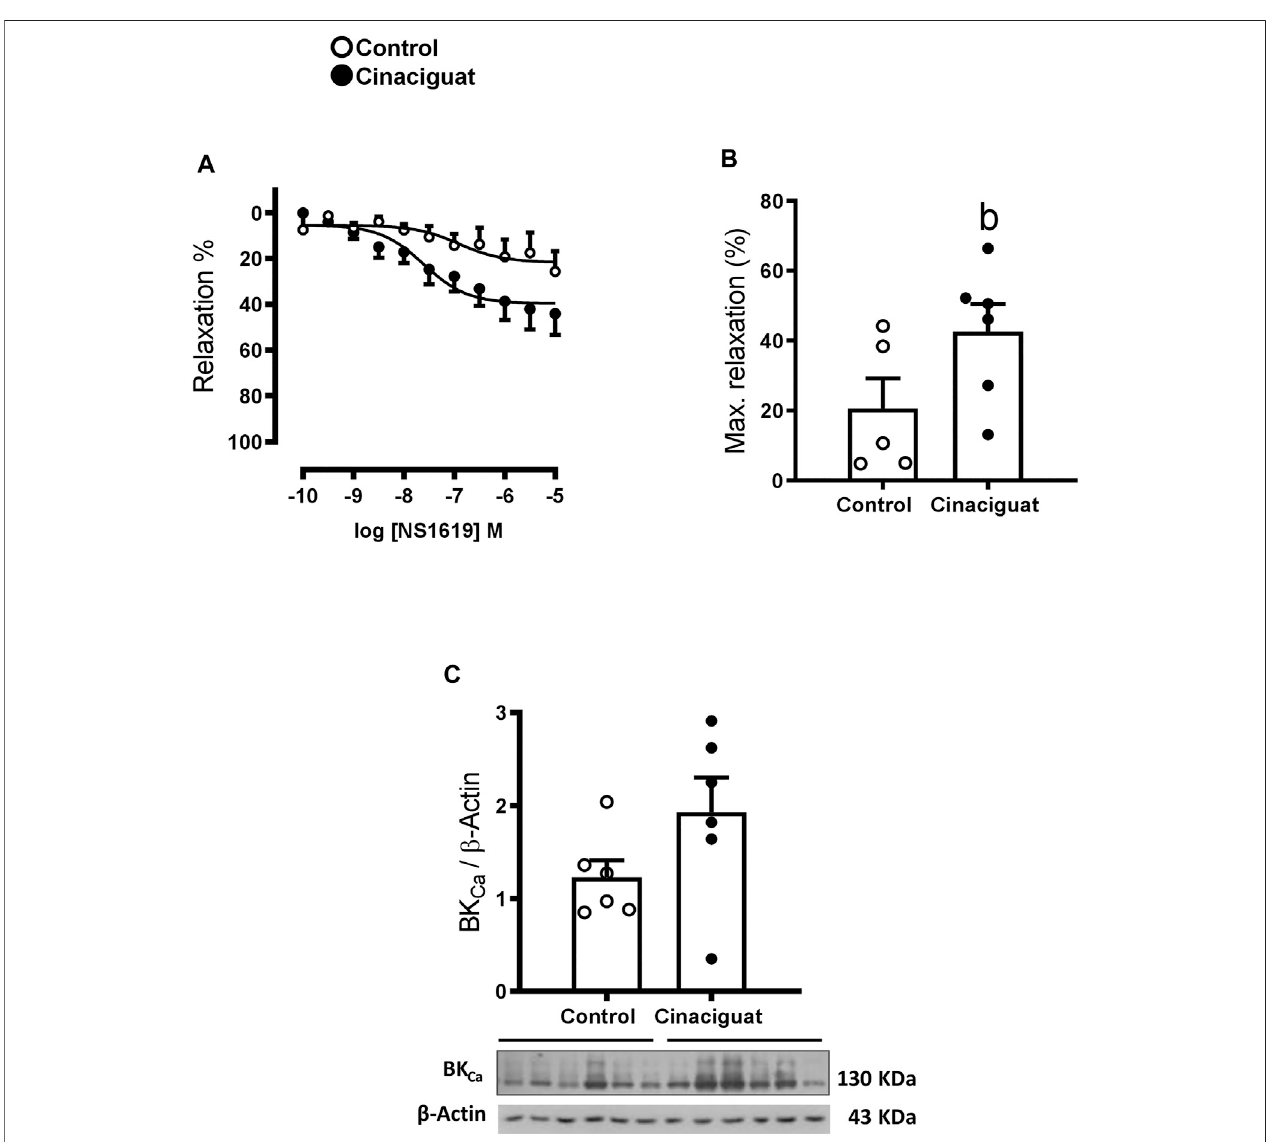
FIGURE 10 | Effect of Cinaciguat treatment on vasodilator function in isolated small pulmonary arteries and lung tissue BK Ca protein expression in chronically hypoxicandpulmonaryhypertensiveneonatallambs.ResponsestoNS1619,BK Ca channelstimulator,insmallpulmonaryarteries,Y-axisshowrelaxation(%),X-axislog NS1619 M concentration (M) (A) . Histogram show maximal relaxation (%) (B) . WB of BK Ca / β -Actin (C) . The β -Actin image was re-used for illustrative purposes. For NS1619 studies, Control (Open circles, n = 5) and Cinaciguat-treated lambs (Black circles, n = 6). For BKCa WB, Control (Open circles, n = 6) and Cinaciguat- treated lambs (Black circles, n = 6). Values are means ± SEM. Signi fi cant differences ( p ≤ 0.05): b vs. Control group.